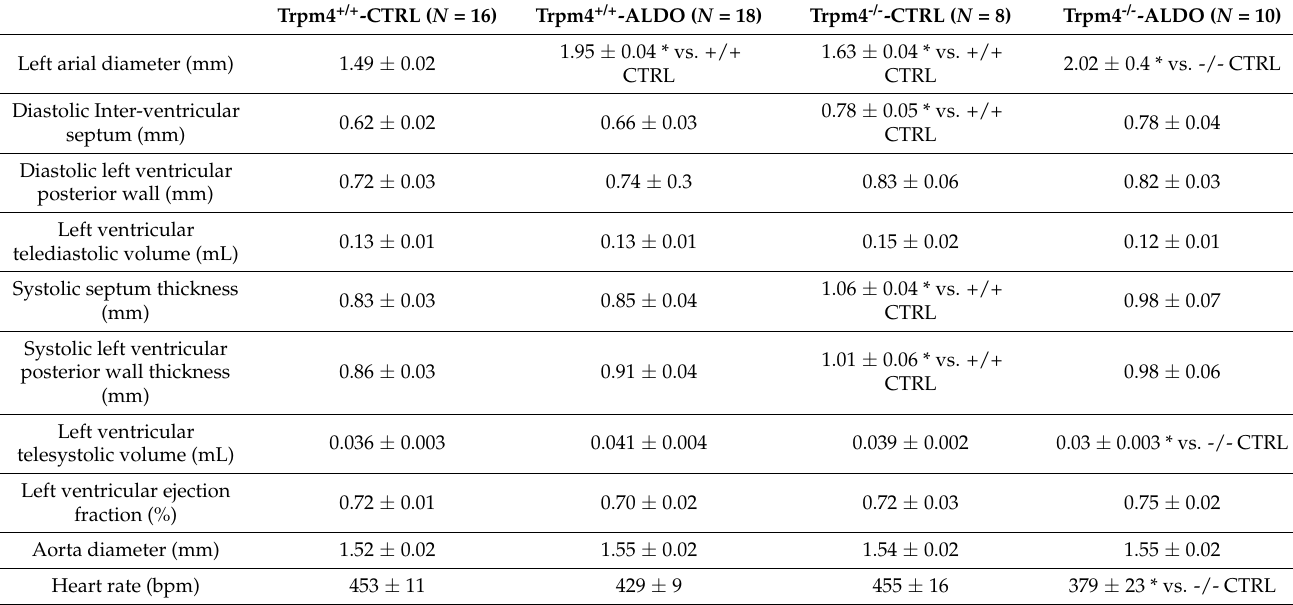
Table 1. Transthoracic echocardiography